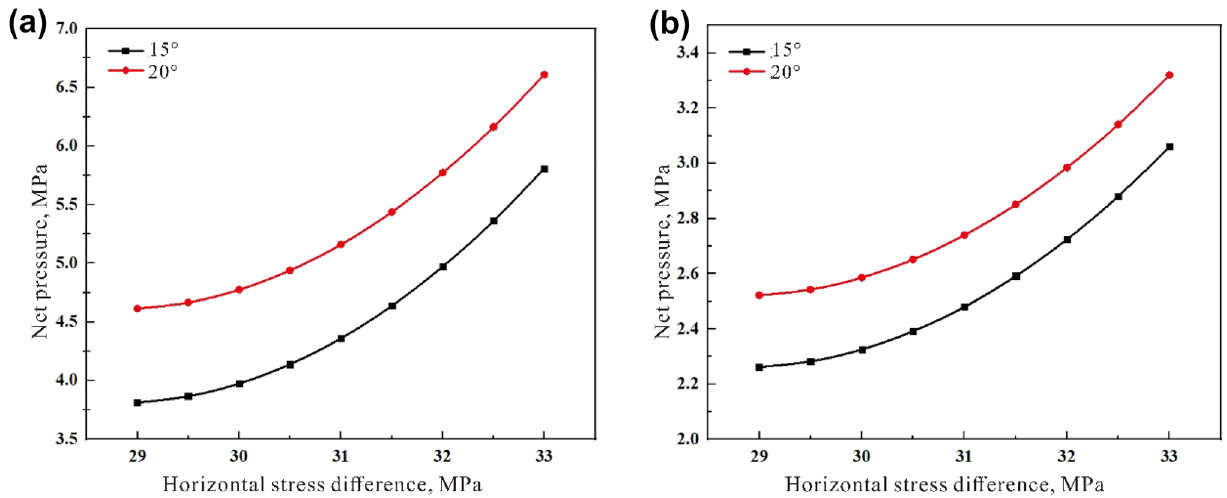
Fig. 2 Pressure conditions of natural fracture activation under different angles between natural fracture and artificial fracture ( a ) and extension ( b